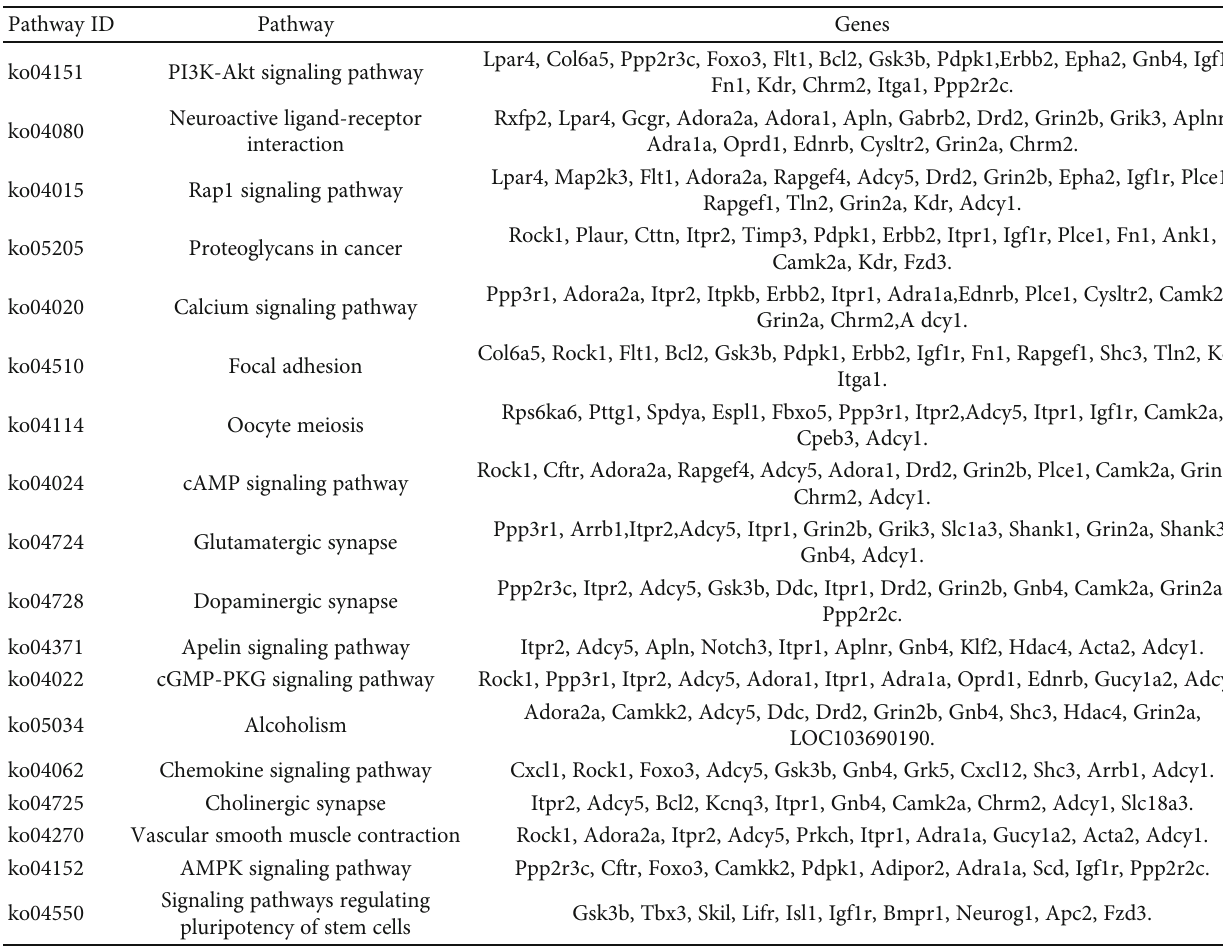
Table 4: A list of the top 18 KEGG pathway